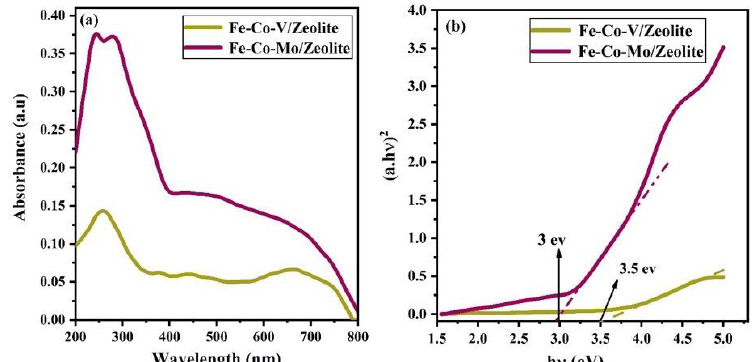
Figure 6. (a) UV-Vis DRS absorption patterns and (b) the corresponding Tauc plots for Fe-Co-V/Zeolite and Fe-Co-Mo/Zeolite CNs.